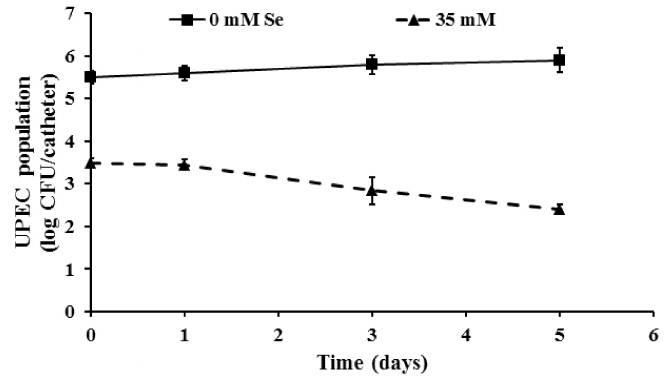
Figure 1. Inhibition of uropathogenic Escherichia coli (UPEC) biofilm formation on urinary catheters by